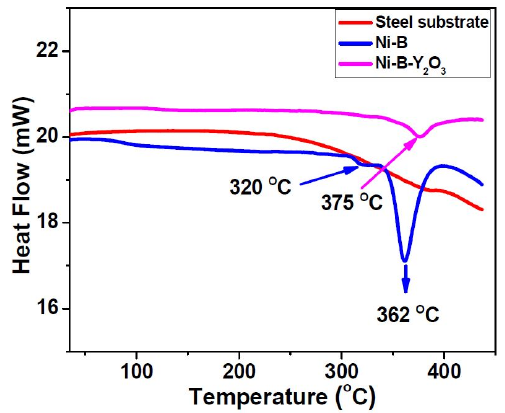
Figure 5. Thermal analysis of electrodeposited Ni ‐ B and Ni ‐ B ‐ Y 2 O 3 composite coatings.